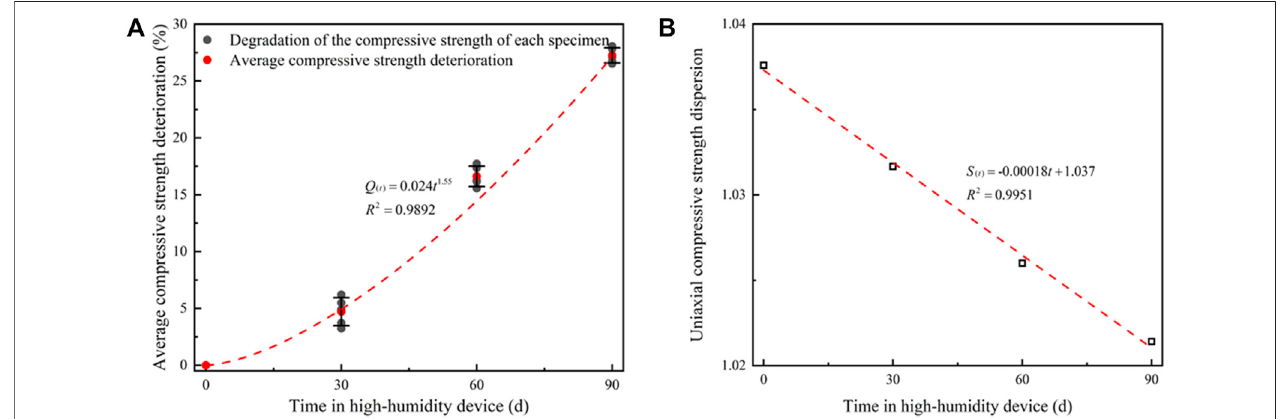
FIGURE8| Uniaxialcompressivestrengthlaw: (A) thedegradationofdolomiteuniaxialcompressivestrength underdifferenthigh-humidityactiontimes; (B) trends in uniaxial compressive strength dispersion of dolomite under different high-humidity action times.